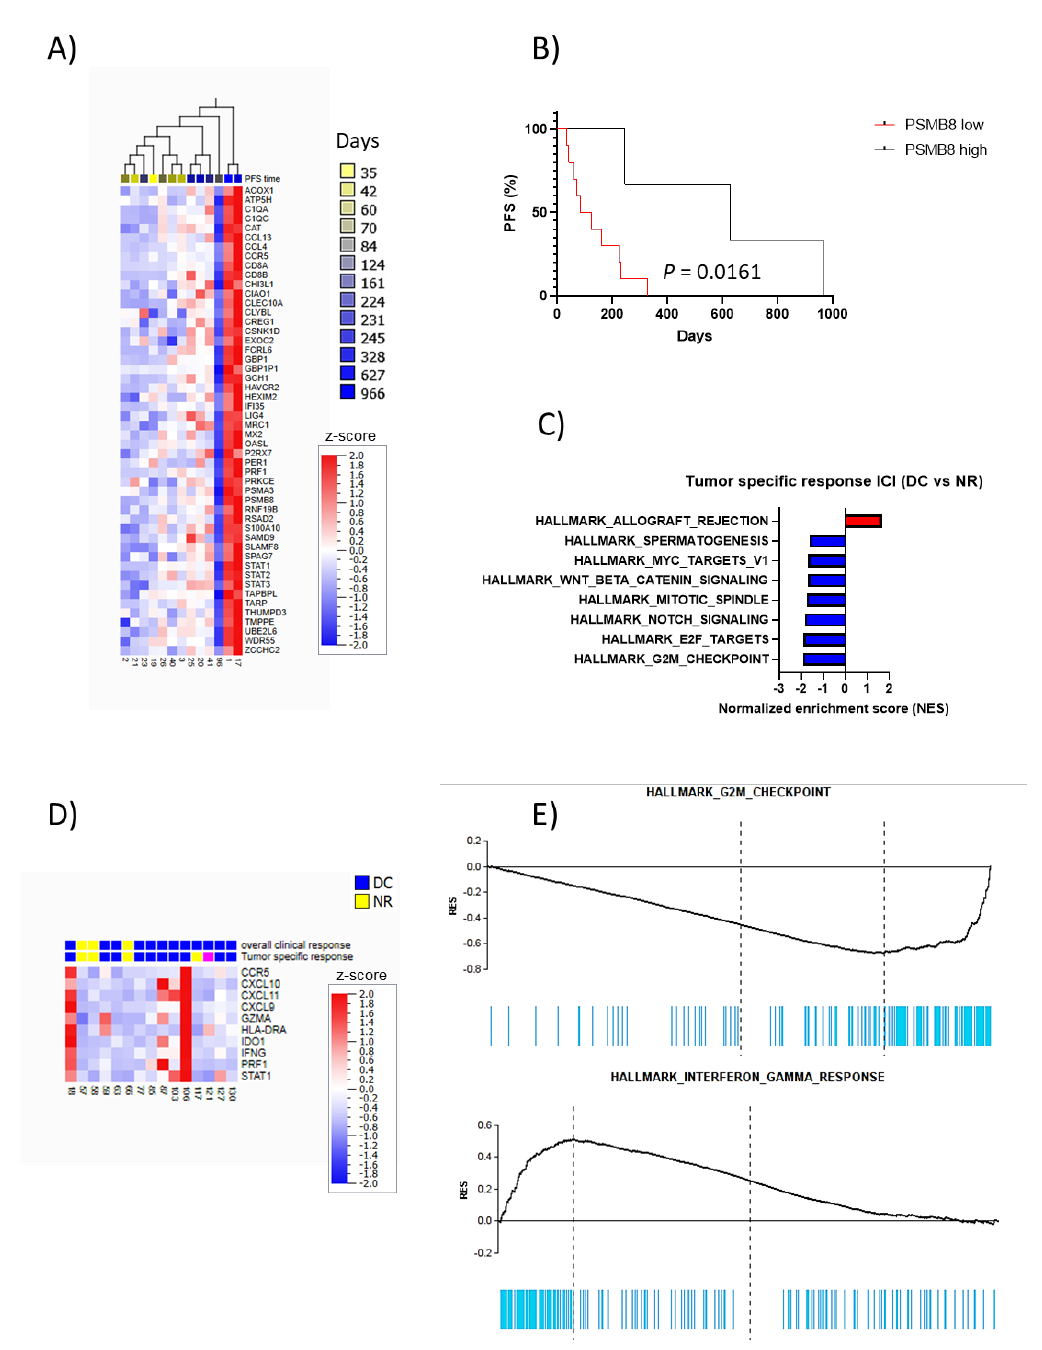
Figure 2. High expression of PSMB8 is associated with longer PFS in patients treated with TT ( A ): Heatmap for hierarchal clustering of the top 50 differentially expressed genes in relation to PFS in patients treated with TT. ( B ): Kaplan–Meier curves showing effects on PFS for patients treated with TT based on the high or low expression of PSMB8 (cut-off: 3rd quartile). ( C ): GSEA shows gene sets with the highest normalized enrichment score when comparing tumor-specific DC versus NR after ICI treatment. All except allograft rejection have an FDR < 20%, which has an FDR of 23%. ( D ): Heatmap performed for expression of genes in the IFN- γ signature, previously reported in the literature, in relation to the tumor and clinical response to ICI treatment in our cohort; DC (blue), NR (yellow), and not evaluable (pink). ( E ): GSEA plots showing a reverse expression between G2M checkpoint genes and IFN- γ response genes, with a relative downregulation of G2M checkpoint genes and upregulation of IFN- γ response genes in DC in relation to NR in patients treated with